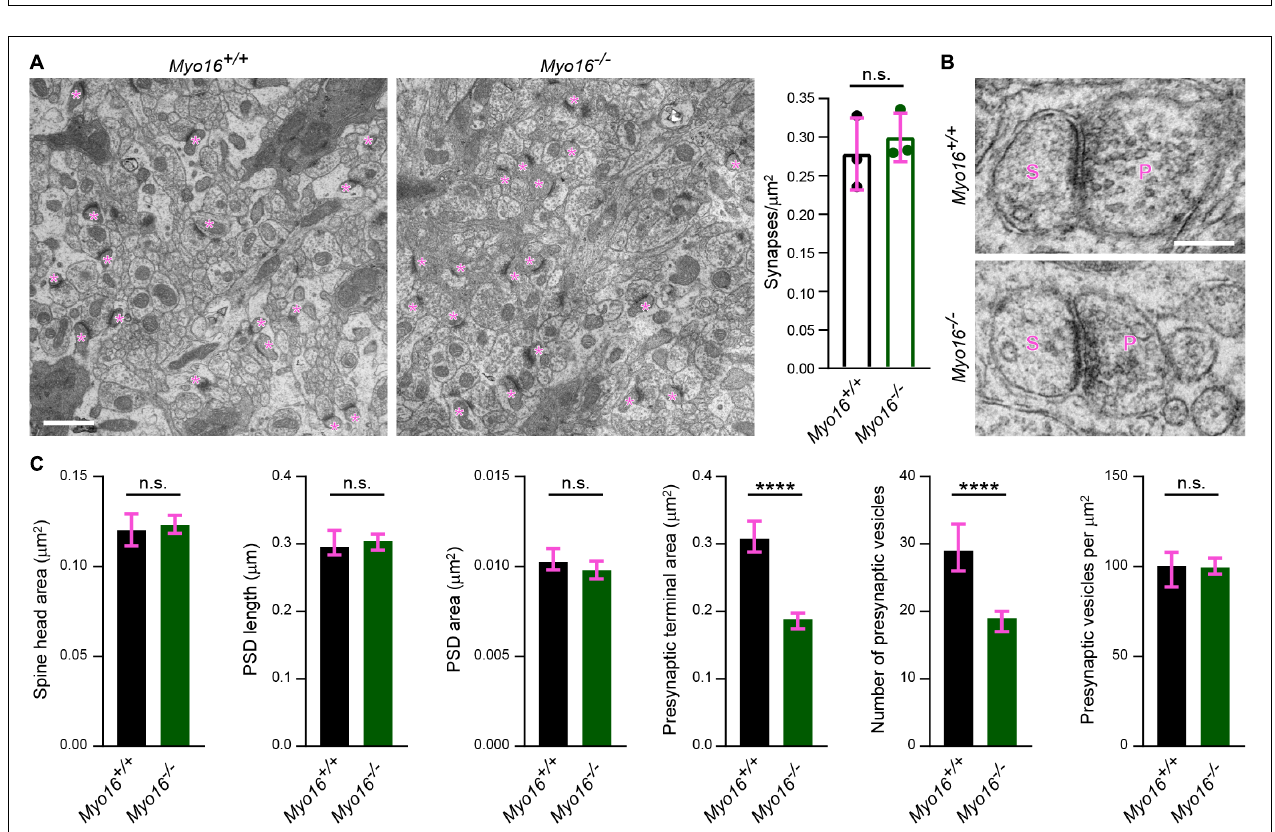
Moreover, PSD length, PSD area and presynaptic vesicle density were unchanged at these synapses ( Figures 8B,C